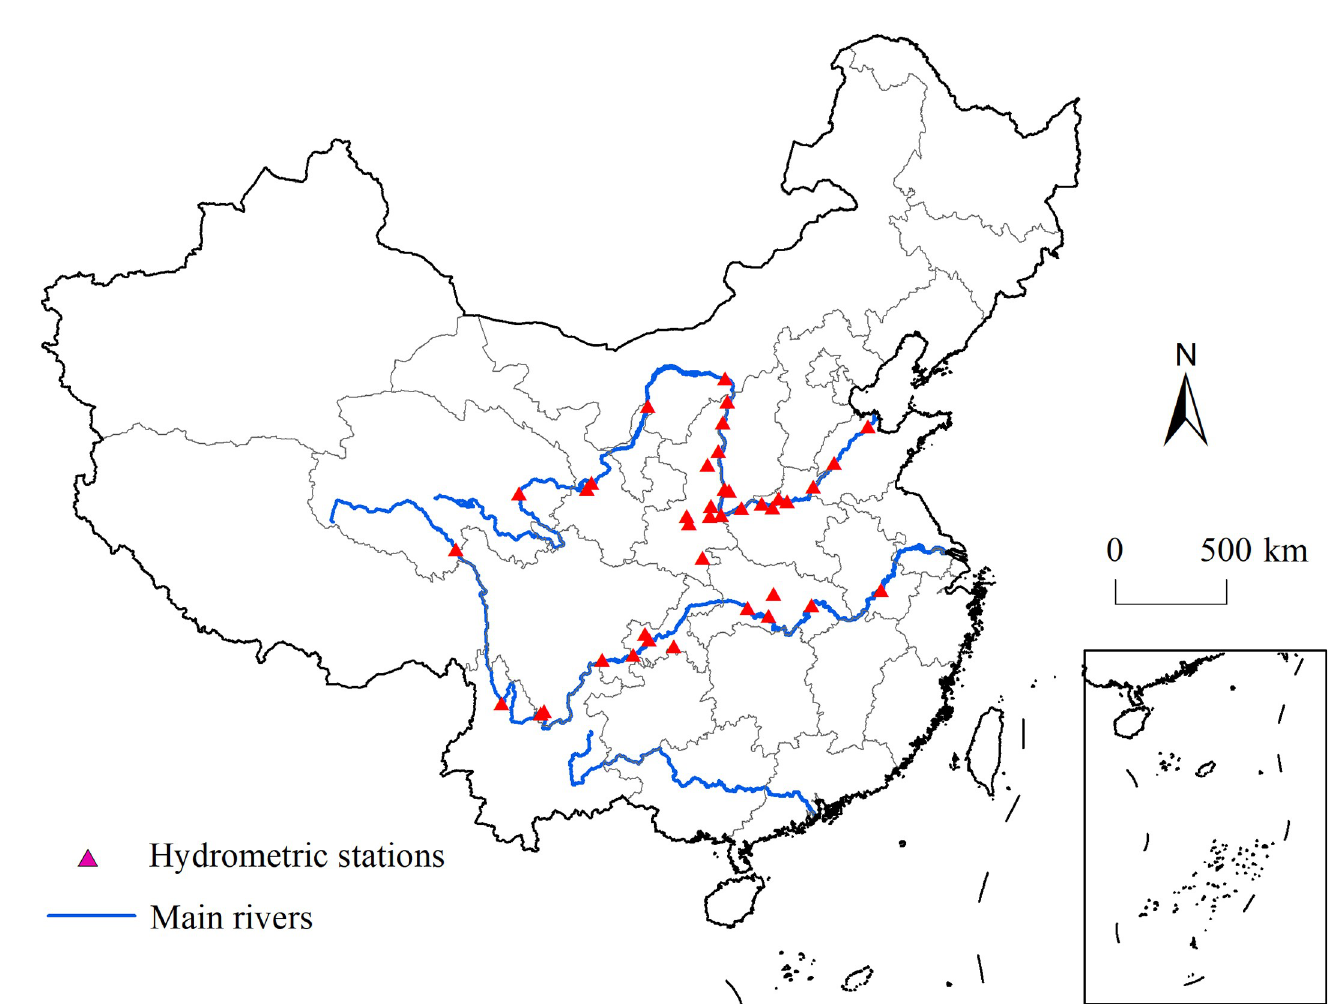
Fig 2. Maps of the main hydrometric stations in the Yangtze River and Yellow